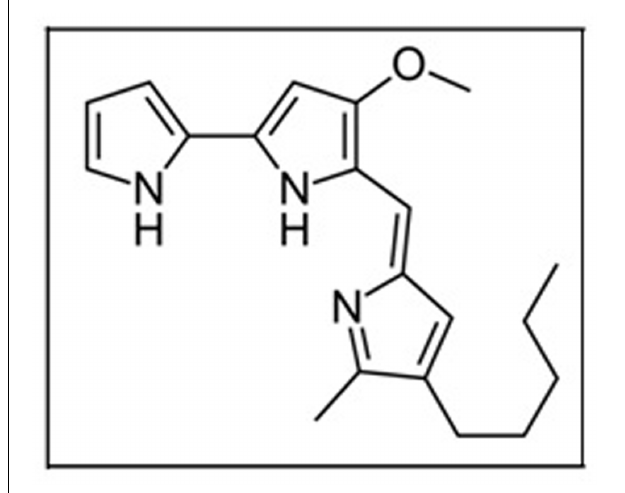
FIGURE 2 | Structure of